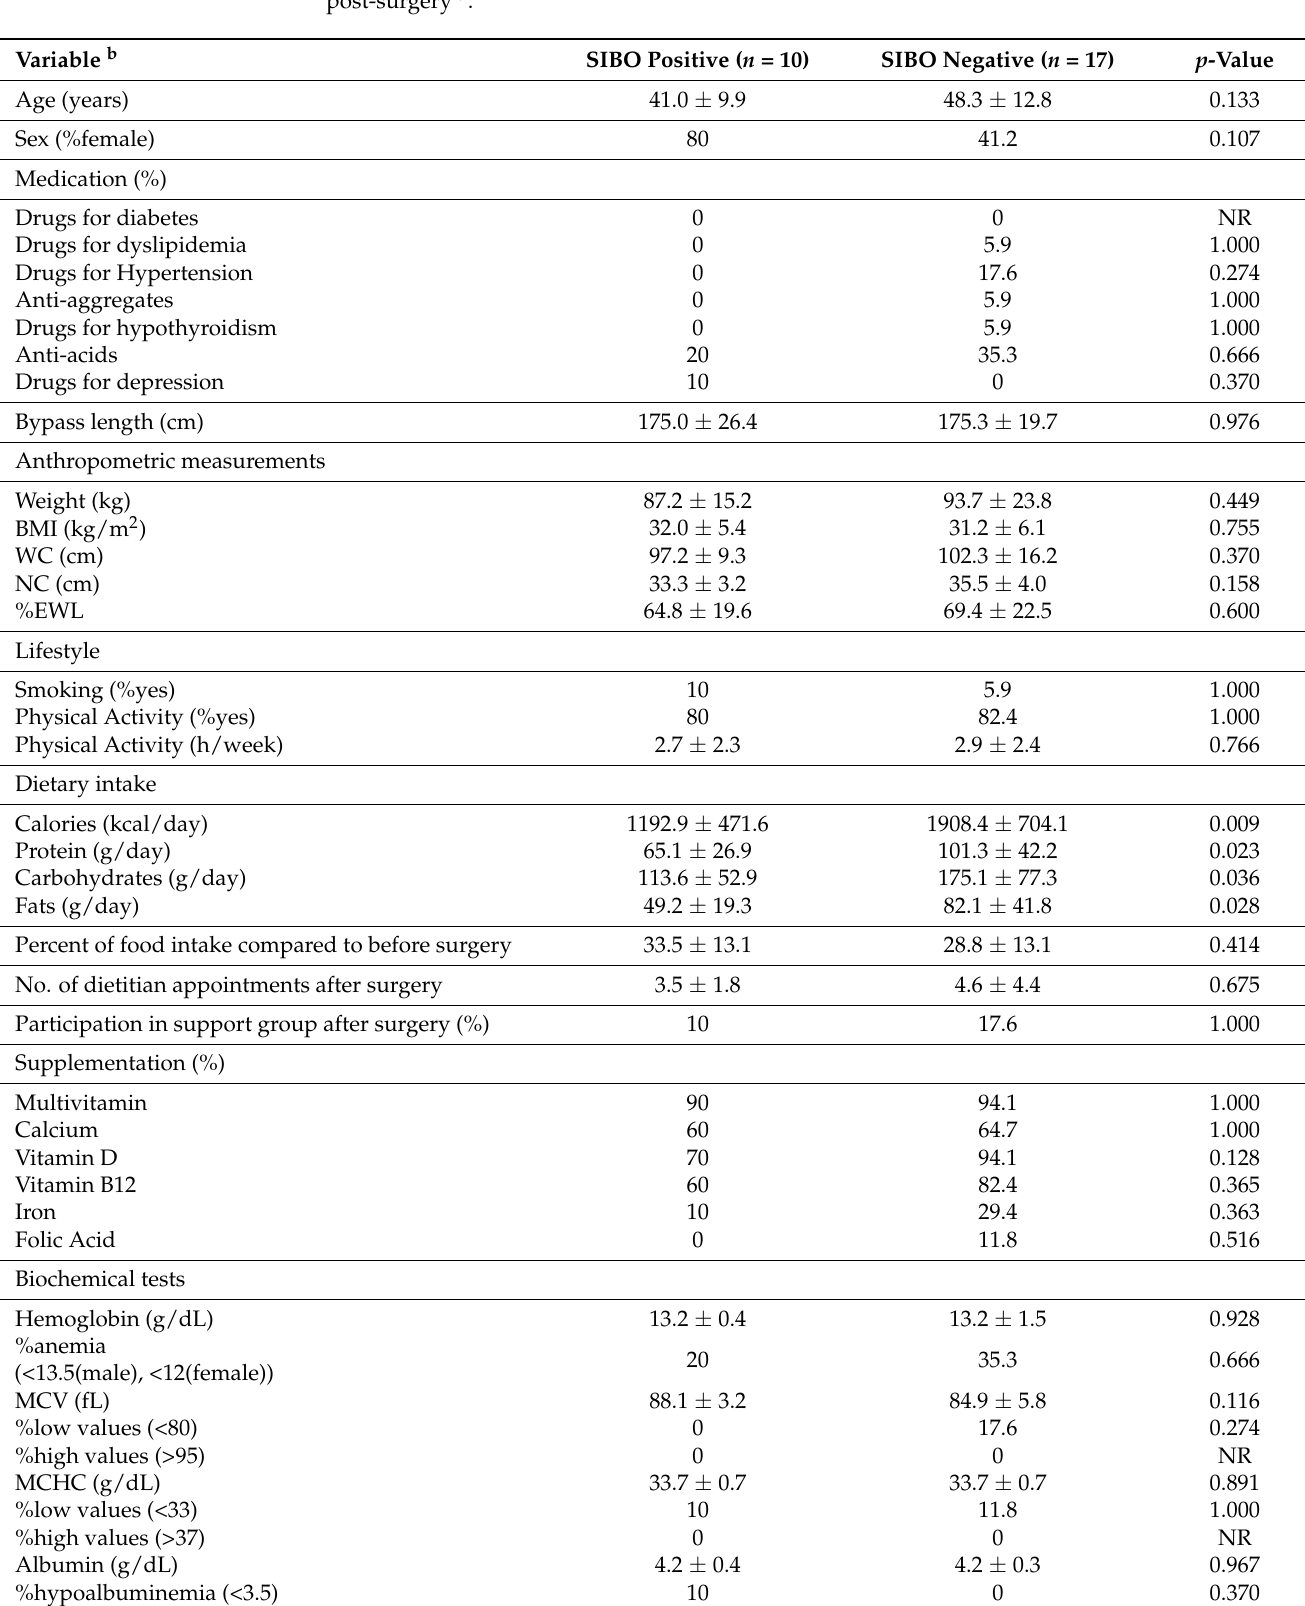
Table 2. Comparison between patients according to their glucose breath-test results at 6 months post-surgery a